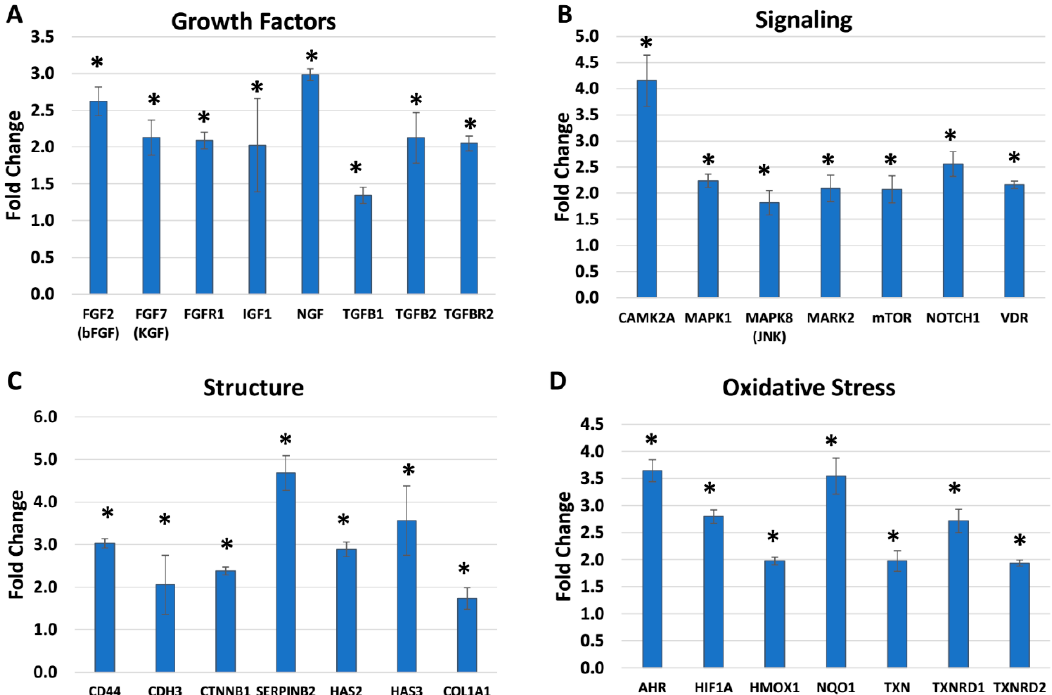
Figure 3. Modulation of gene expression by BlendIP. Skin equivalents were dosed with BlendIP for 24 h. Four hundred forty validated Taqman gene expression assays with relevance to the skin structure and function were examined using OpenArray. Unpaired t -tests were performed using StatMiner, and only statistically-significant fold changes compared to the untreated samples were shown ( p ≤ 0.05). Standard deviation is shown as error bars. ( A ) Gene expression changes on selected growth factors are shown. ( B ) Gene expression changes on selected signaling proteins are shown. ( C ) Gene expression changes on selected skin structure are shown. ( D ). Gene expression changes on selected oxidative stress targets are shown. * indicates statistically-significant increase compared to control values.